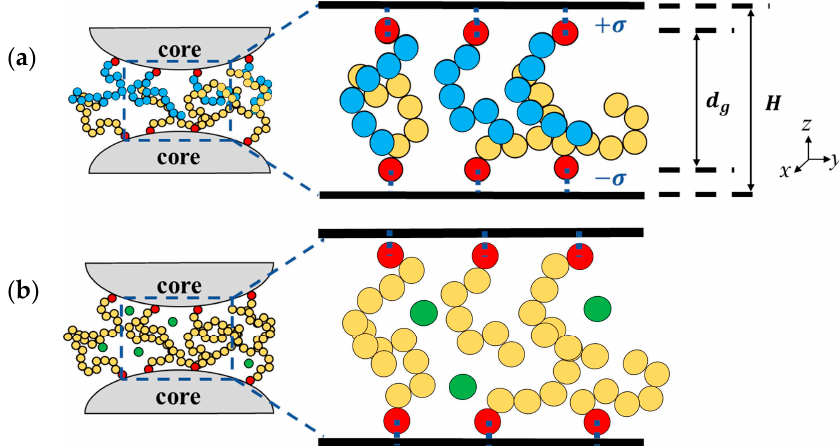
Figure 1. ( a ) Schematic diagram of the binary brush system (right) representing the interstitial space between two neighboring polymer-grafted nanoparticles (left). Red beads are the grafting monomers, and yellow and blue beads are the remaining monomer beads of two types. H is the gap thickness and d g is the distance between the top and bottom grafted beads. ( b ) Same as ( a ), but for the same polymer brushes with added free molecules (green